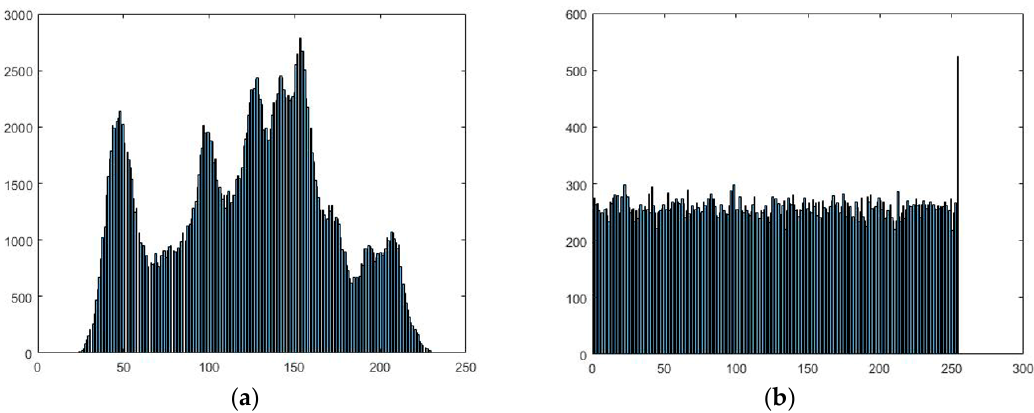
( c ) Figure 7. Experimental results. ( a ) Lena original grayscale image; ( b ) Lena reconstructed image; ( c ) Reconstructed with an incorrect key value. 5.5. Resistance to Statistical Attacks Resistance to statistical attacks is the most basic objective of an image encryption algorithm. Shannon suggested that maximum confusion and diffusion should be employed in a cryptosystem to remove the correlation characteristics of image pixels to frustrate powerful statistical analysis. In the proposed compression and encryption algorithm, we achieve maximum confusion and diffusion at various levels via nonlinear inverse operations, K 2 -tree and multiple chaotic maps in the last stage. After many confusion and diffusion operations were performed through the joint compression and encryption operations, the cipher image shows a truly random distribution. This random distribution of the cipher image was evaluated using histograms, adjacent-pixel correlations, and the information entropy of the cipher image. 5.5.1. Histogram Analysis Figure 8 shows the “Lena” image histograms and, on the right, the corresponding “Lena” cipher image. Figure 8 shows that the histogram of the corresponding cipher image is almost uniformly distributed; therefore, this technique can withstand all types of statistical attacks. We also analyze the distribution of the pixel values of encrypted images through the chi-square test. The chi-square value was calculate using Equation (17).